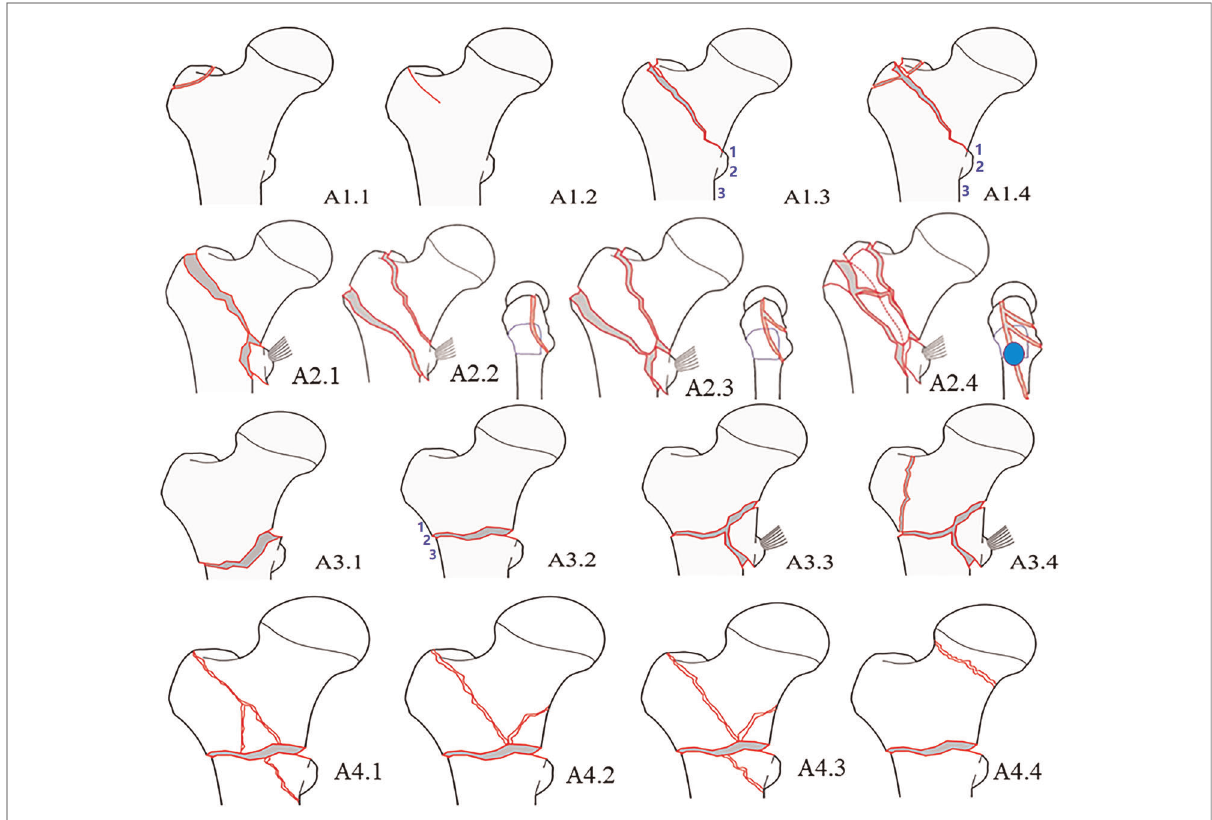
FIGURE 4 Schematic drawing to show a sophisticated fracture classi fi cation of proximal femur trochanteric region AO/OTA-31A.